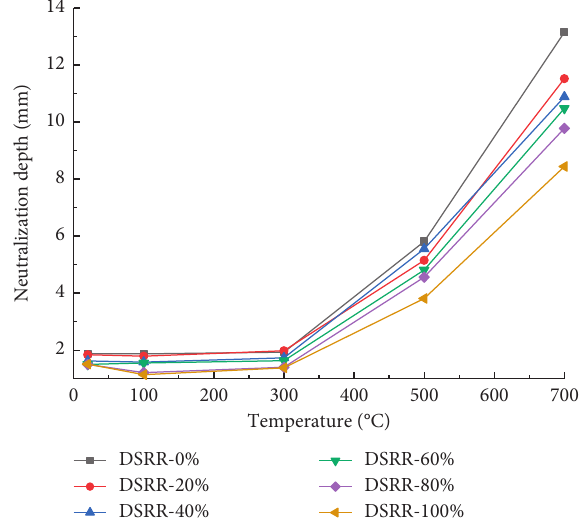
Figure 21: Relation between neutralization depth and temperature.